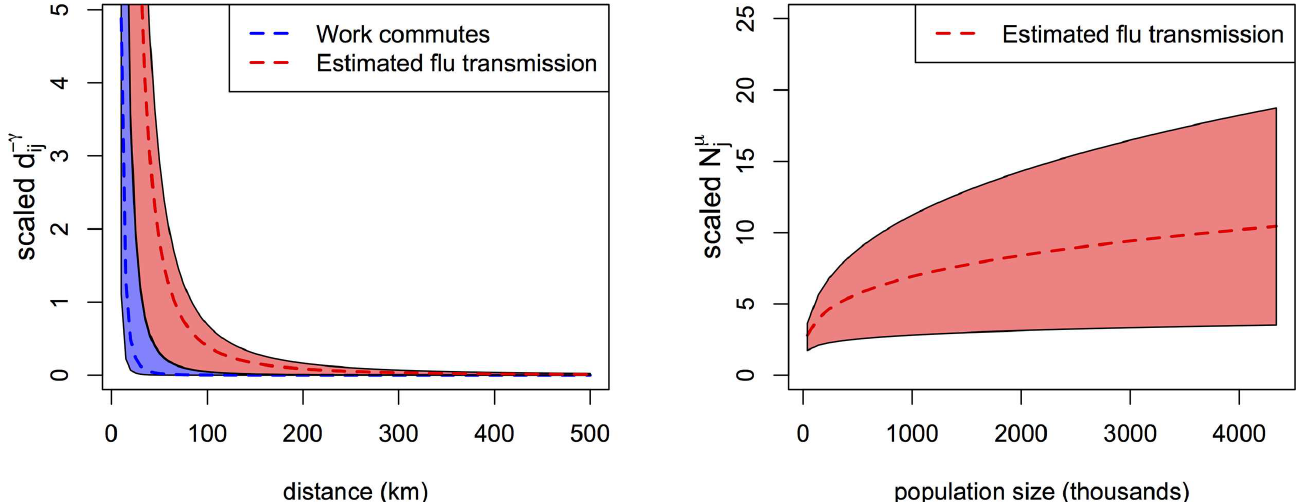
Fig 6. Spatial transmission kernels and demographic effects summarized across seasons. Left panel. Work commutes scale with geographic distanceaccordingto a power law of 3.3 (95% CI: 2.66 to 3.95); this relationshipis depicted in blue (See also supporting S1 Text, Figure A6). Based on our distance-based transmission model, the force of infectionbetweenan infectiousand susceptiblecity, λ ij , scales with geographicdistanceaccording to a medianestimated power law of 2.2 (range: 2.08 to 2.65), depicted in red. This indicatesthat for a 10-fold decreasein distancebetweenan infectiousand susceptiblepair of cities, the hazardof infectionon the susceptiblecity increasesby a factor of ~158 (range: 120–467).Right panel. The force of infectionon a susceptible city, λ j , scales with its populationsize accordingto a median estimated power law of 0.28 (range: 0.15 to 0.35). This indicatesthat for a 10-fold increasein populationsize, the hazard of infection on the susceptible city increasesby a factor of 1.9 (range: 1.4–2.2).